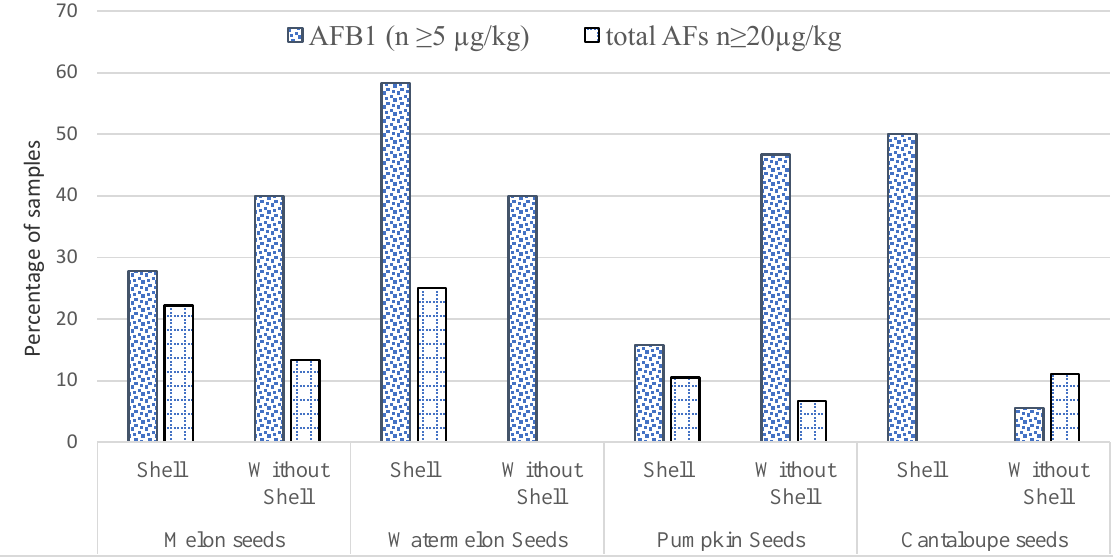
Figure 3. The number of AFB1 and total AFs (µg/kg) samples higher than the recommended EU limits from the winter season.